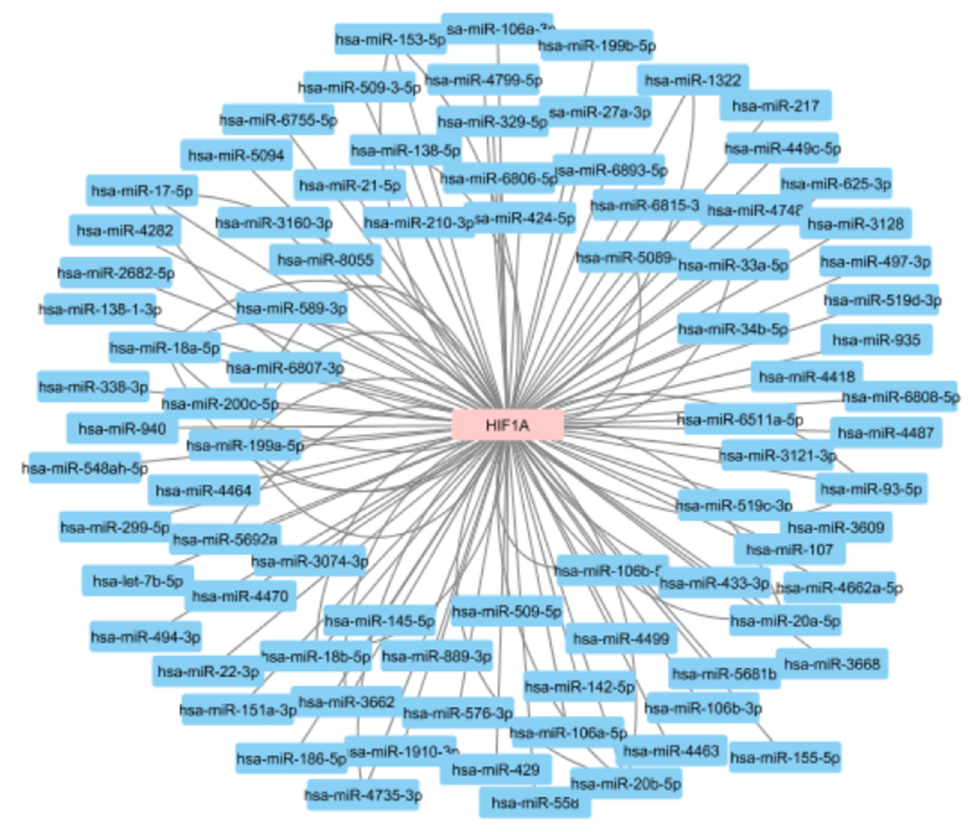
Figure 8. MicroRNAs reported to regulate the HIF1A gene. The data obtained from the miRTar- Base.